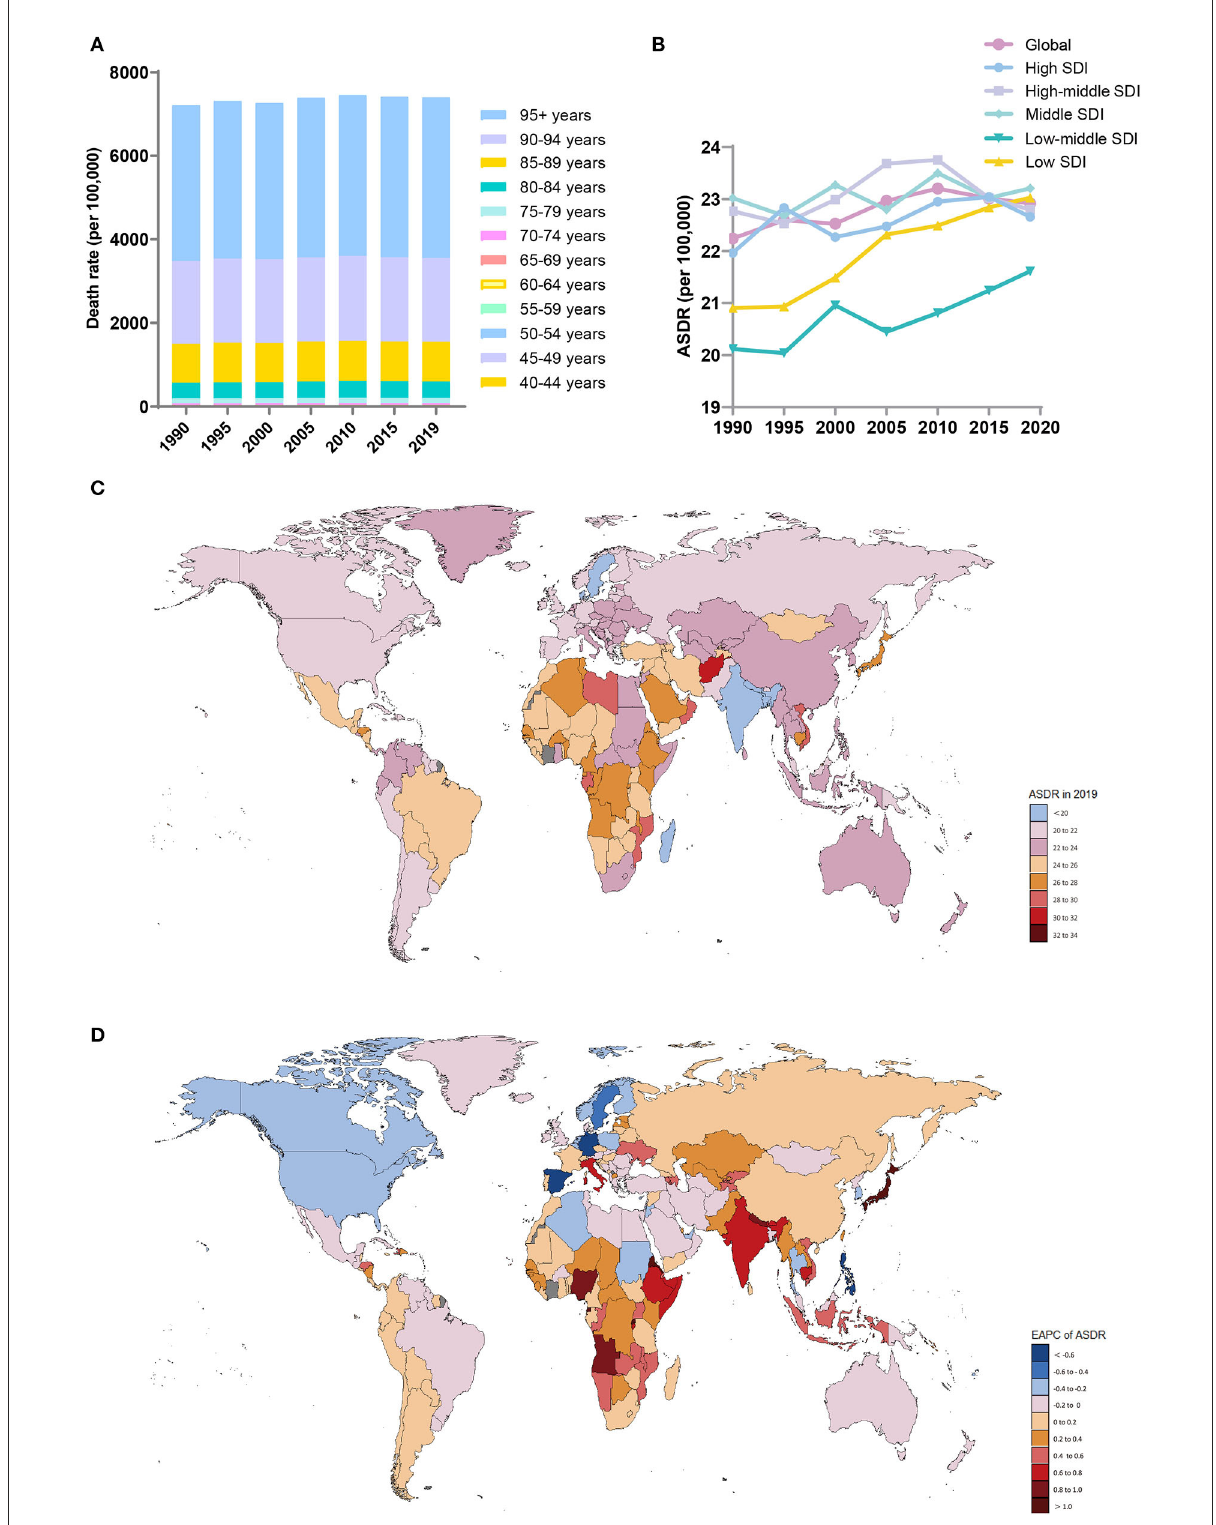
FIGURE3 Distribution of deaths due to Alzheimer’s disease and other dementias in 204 countries and territories from 1990 to 2019 by age group and SDI region. (A) Death rate in each age group; (B) Trends of the ASDRs in the SDI region; (C) ASDRs in 204 countries and territories; (D) EAPCs of the ASDRs in 204 countries and territories. SDI, sociodemographic index; ASDR, age-standardized death rate; EAPC, estimated annual percent